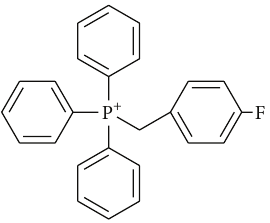
Figure 7: Structure of [ 18 F]- p -fluorobenzyl triphenylphosphonium cation ( 18